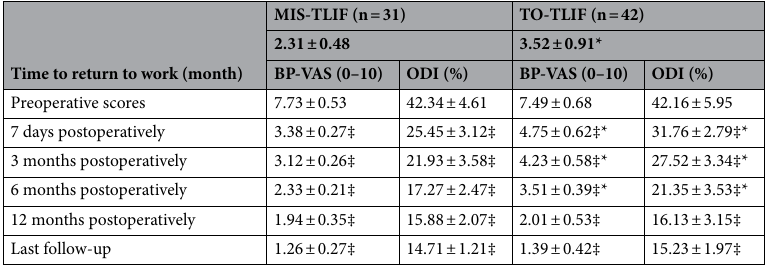
Table 3. Comparation of patient-reported outcome measures. * P < 0.05, comparation of indicators at each time point between the two groups. ‡ P < 0.05, Scores at each time point postoperatively versus preoperative score. BP-VAS: low-back pain VAS scores.